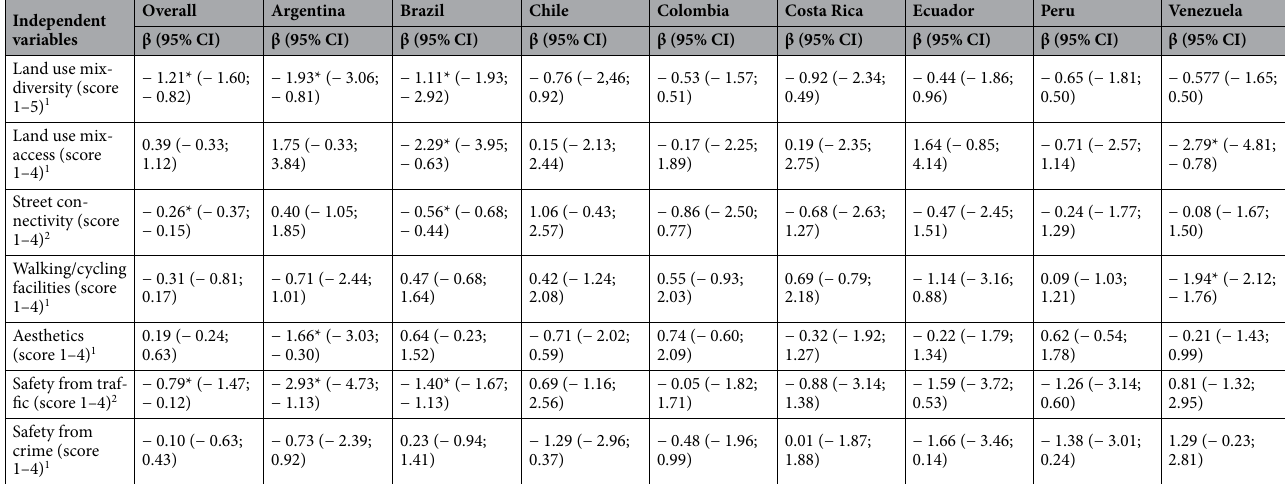
Table 3. Linear regression models (unstandardized β, 95% CI) for perceived urban environment attributes and waist circumference (cm). Linear regression models adjusted for age, sex, marital status, work status, socioeconomic level, and energy intake; work status, socioeconomic level, and energy intake. *Indicates statistically significant associations (p < 0.05). CI confidence interval. 1 Higher scores indicate perception of higher land use mix− diversity, higher land use mix-access, more walking/cycling facilities, better aesthetics, and more safety from crime. 2 4-point scale: strongly disagree (1), disagree (2), agree (3), strongly agree